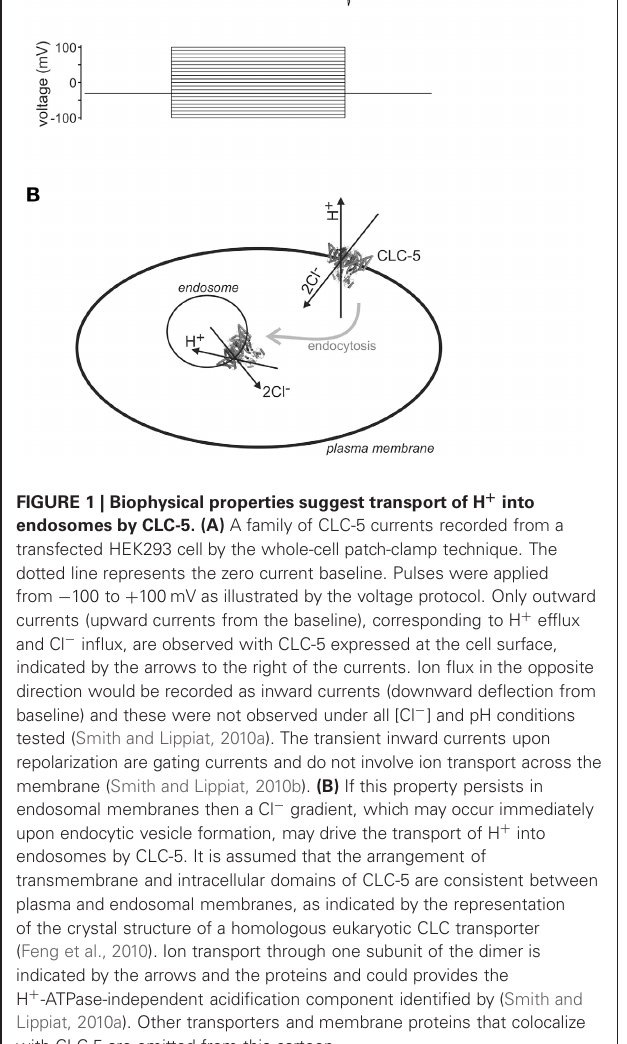
H + from and Cl − into the cytoplasm ( Figure 1 ). One